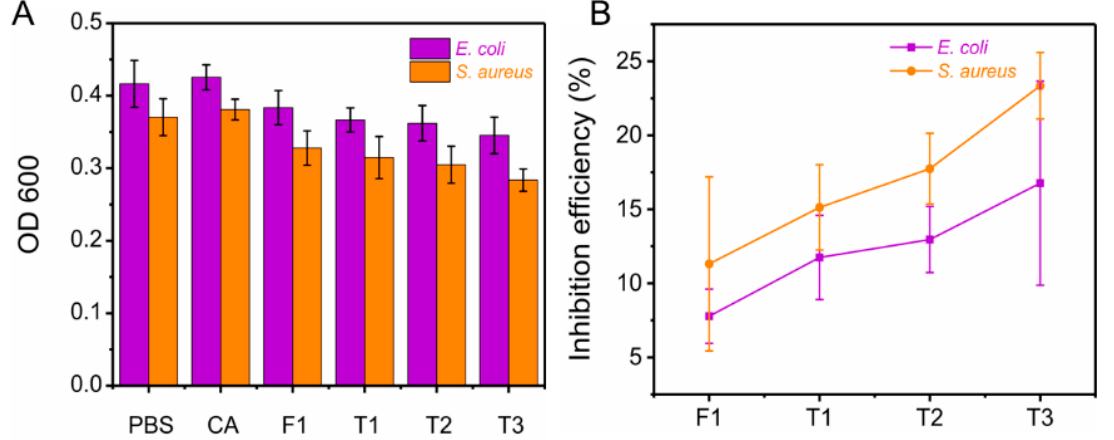
Figure 7. Antibacterial activity of four prepared fibers and control samples (PBS and blank CA fibers). ( A ) OD 600 of bacterial liquid cultured with samples for 24 h. ( B ) Antibacterial efficiency of four prepared fibers.